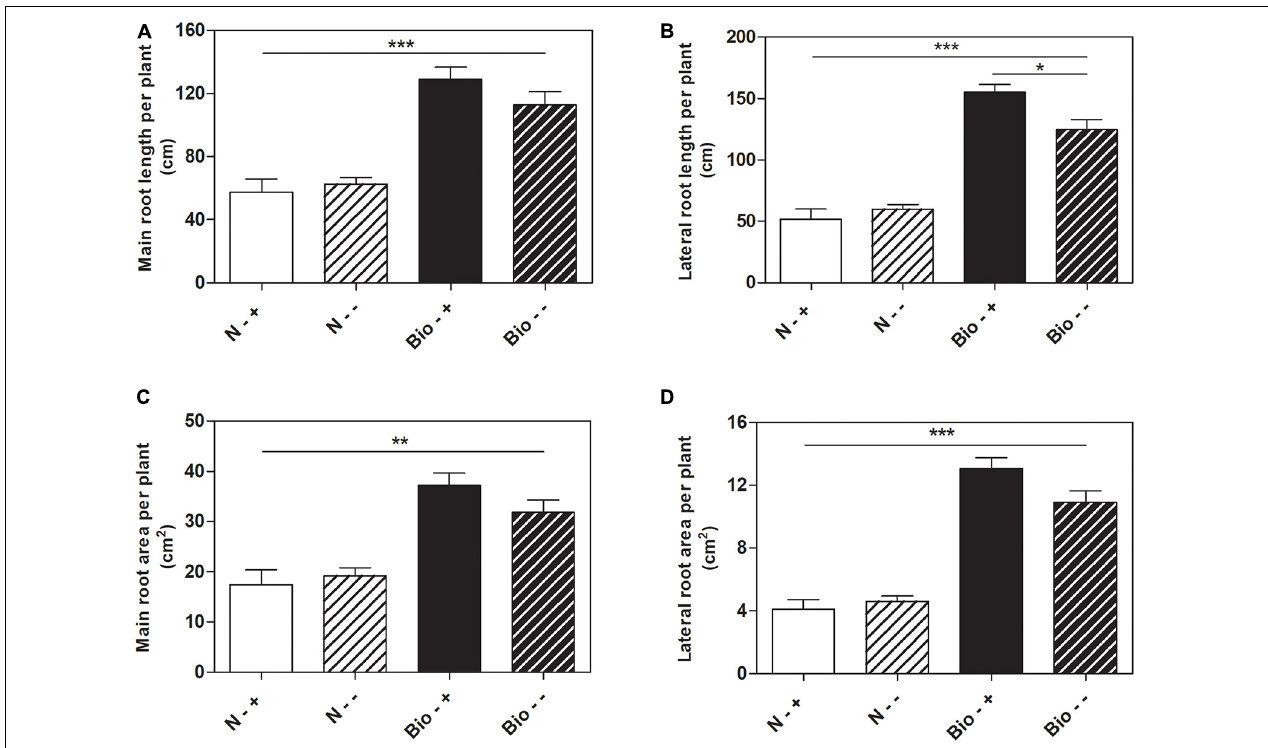
FIGURE 3 | Effects of the PH on root growth of maize plants after recovery from hypoxic stress. Total seminal and primary root length (A) , lateral root length (B) , total seminal and primary root area (C) , lateral root area (D) , of maize seedlings treated with 0.1 mL L − 1 PH (Bio) and seedlings treated with equivalent amounts of total N (14.3 mg L − 1 ), supplied as inorganic nitrogen (N). The seedlings were hydroponically grown under hypoxia for 5 days, and then kept under normal air flow or hypoxic stress for further 4 days. Root length and root area were measured with WinRHIZOTM software. Mean values per plant are reported. Bars represent the standard error (SEM) ( n ≥ 7), Student’s t -test was applied, * p < 0.05; ** p < 0.01; *** p <